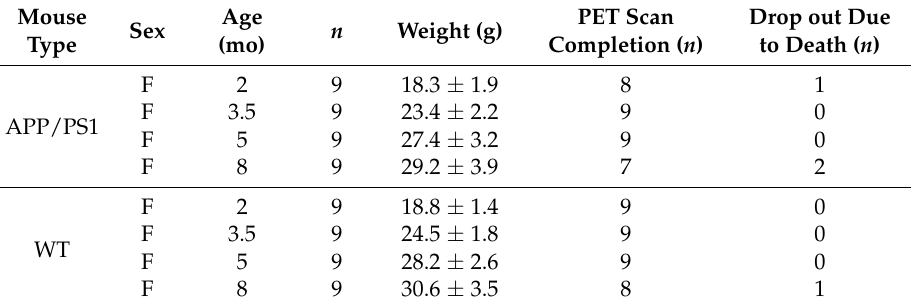
Table 1. Demographics and overview of mice used in the study.